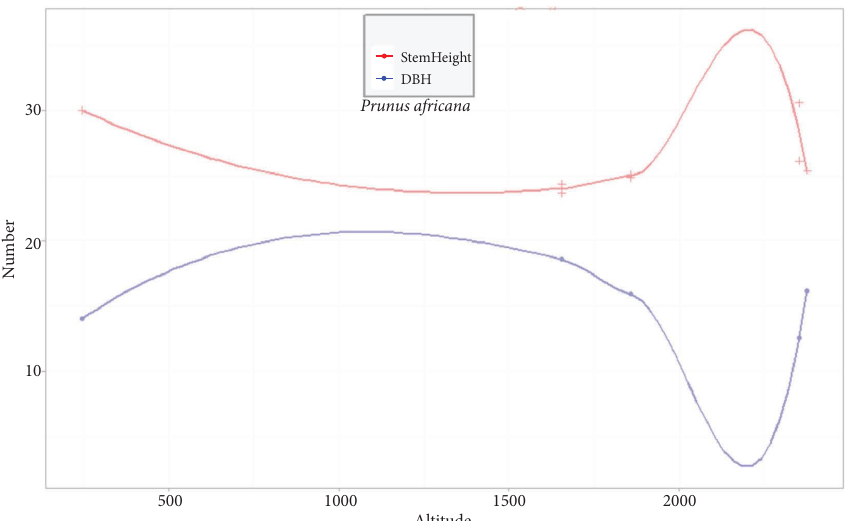
Figure 9: Distribution of stem height and DBH of P. africana along altitudinal